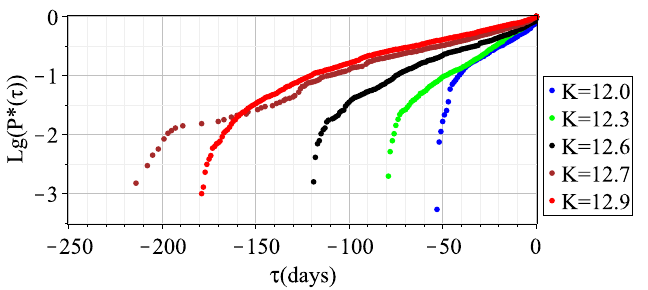
Figure 4. The plots of eCDF P ∗ ( τ ) of foreshock waiting time for the mainshocks of energy classes 12.0, 12.3, 12.6, 12.7, and 12.9 on a logarithmic scale.